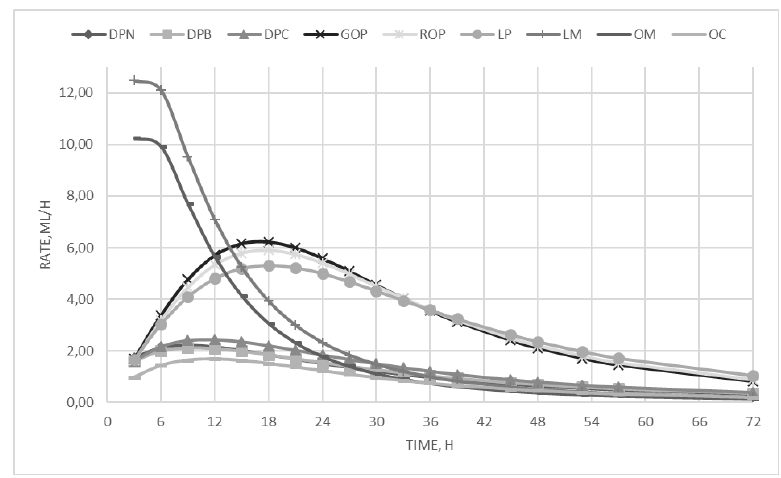
Figure 1. In vitro fermentation rate over time.